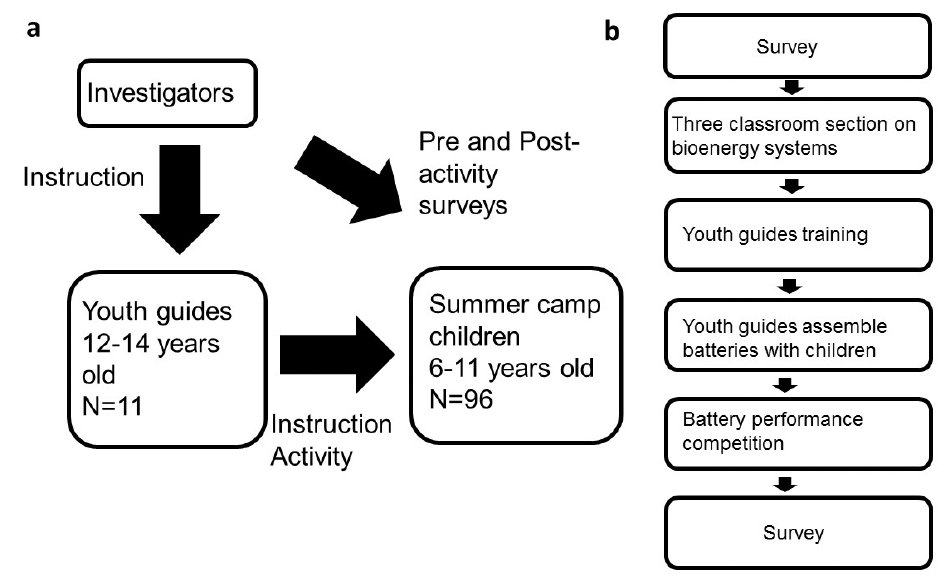
Figure 3. Educational activity description. ( a ) The schematic description of the educational activity involving youth leader and children in the summer camp. ( b ) Teaching materials, lectures, and activity structure as performed during the